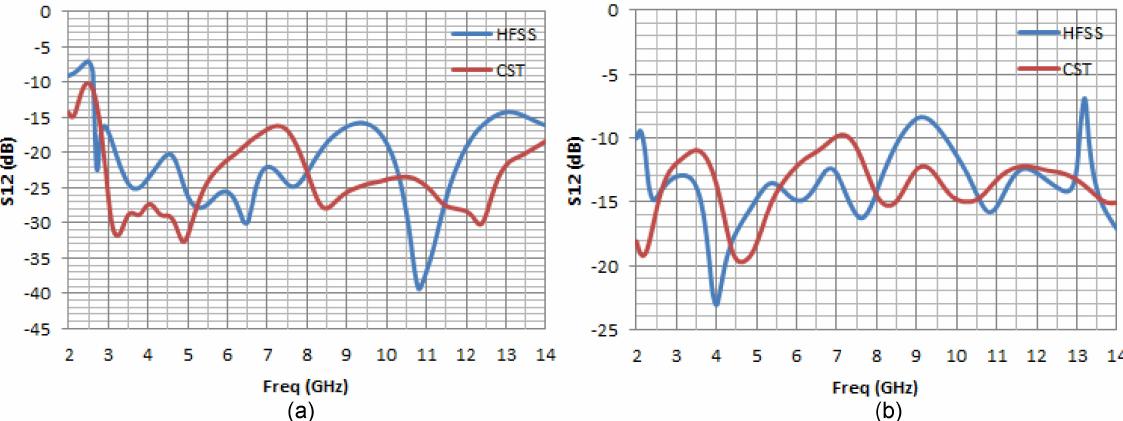
Figure 15. MIMO − UWB antenna S − parameter (S 12 ) using HFSS and CST software ( a ) with MEBG, ( b ) without MEBG.